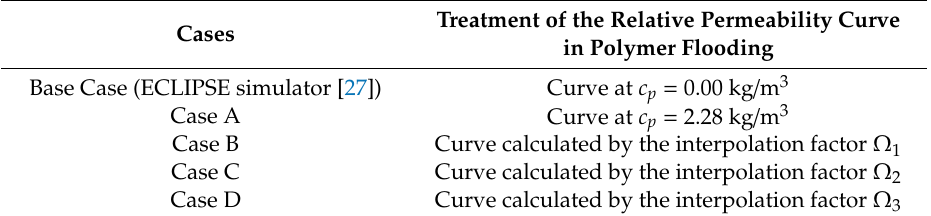
Table 3. Model setting of the cases study.